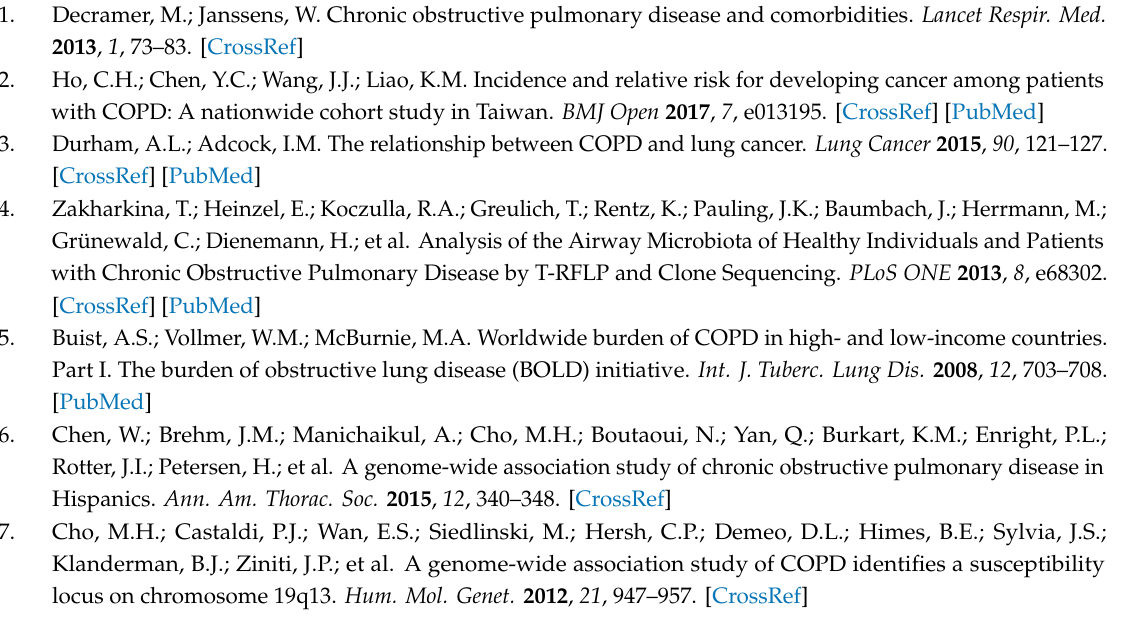
Figure S1: Network of miRNAs with elevated abundance in surviving patients. mRNA-targets that are predicted for two miRNAs are indicated in blue and mRNAs that are predicted to be targeted by three miRNAs are indicated in orange. SP1: Sp1 transcription factor, TGFBR1: transforming growth factor beta receptor 1, IGF1R: insulin-like growth factor 1 receptor, GNAI1: G protein subunit alpha i1., Table S1: The 15 miRNAs with the most significant di ff erential abundance between the surviving and the non-surviving patient